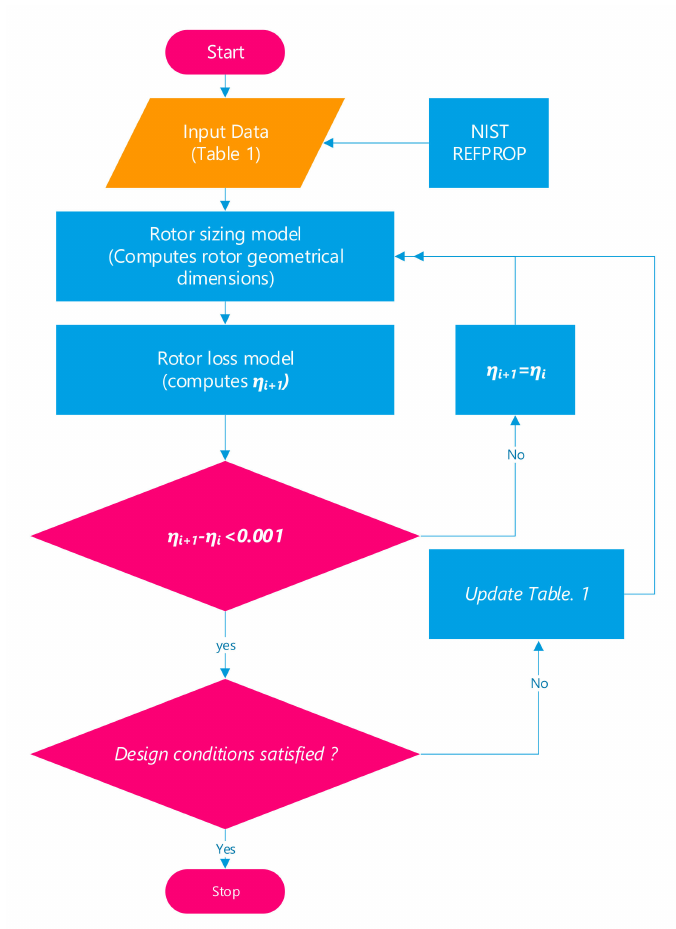
Figure 5. Flow diagram for the meanline design